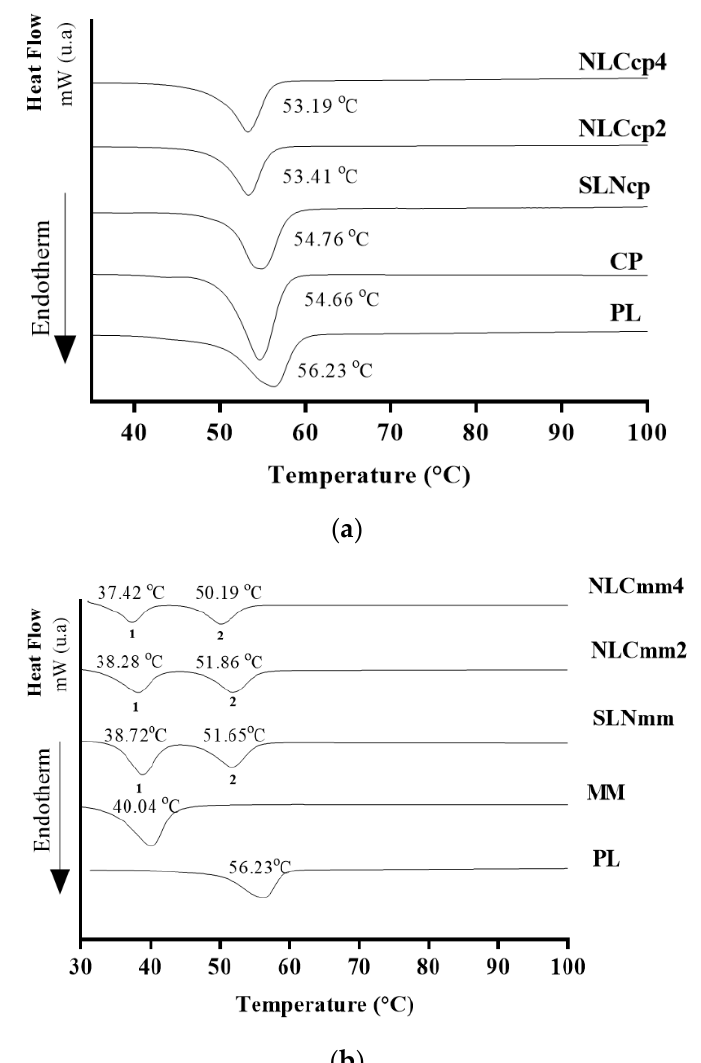
Figure 5. DSC curves of lipid nanoparticles and their compounds. Lipid nanoparticles produced with cetyl palmitate ( a ) and myristyl myristate ( b ). The melting points of the first and the second peak of samples were represented by numbers 1 and 2 respectively. Table 2. DSC analysis of lipid nanoparticles produced with cetyl palmitate and myristyl myristate and their compounds (PL, CP, and MM).